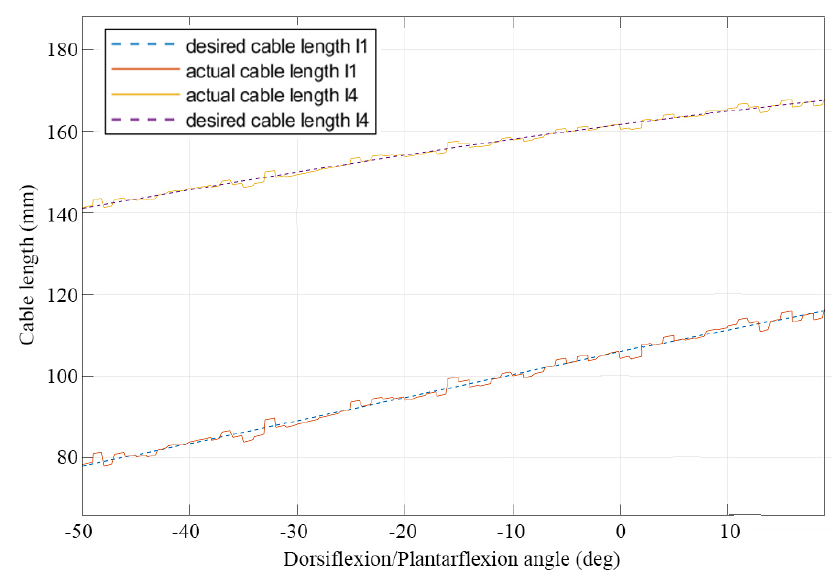
Figure 9. Desired and computed cable length values for a simulated operation of a controlled ankle assisted motion exercise.